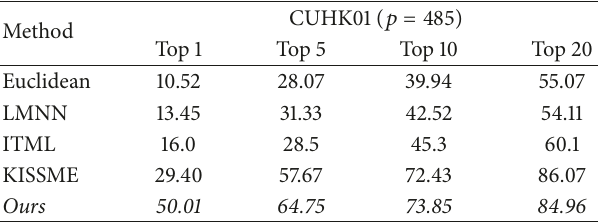
Table 5: Comparison of state-of-the-art results of metric learning reported with CUHK01 database. The cumulative matching scores (%) at ranks 1, 5, 10, and 20 are listed.